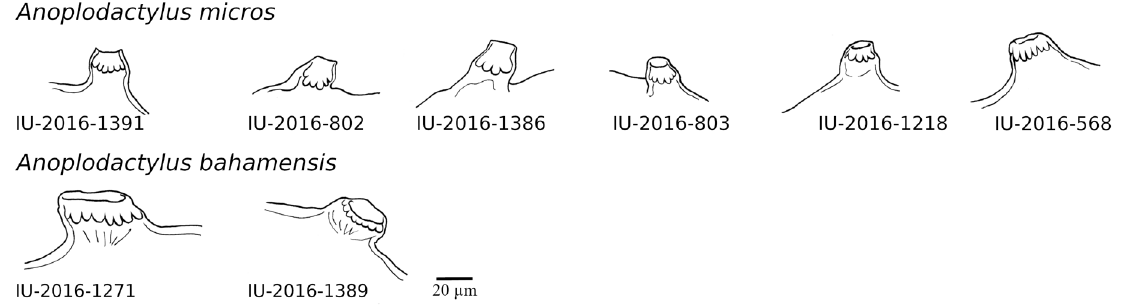
Fig. 20. Cement gland pores of Anoplodactylus micros Bourdillon, 1955 and A. bahamensis Child,